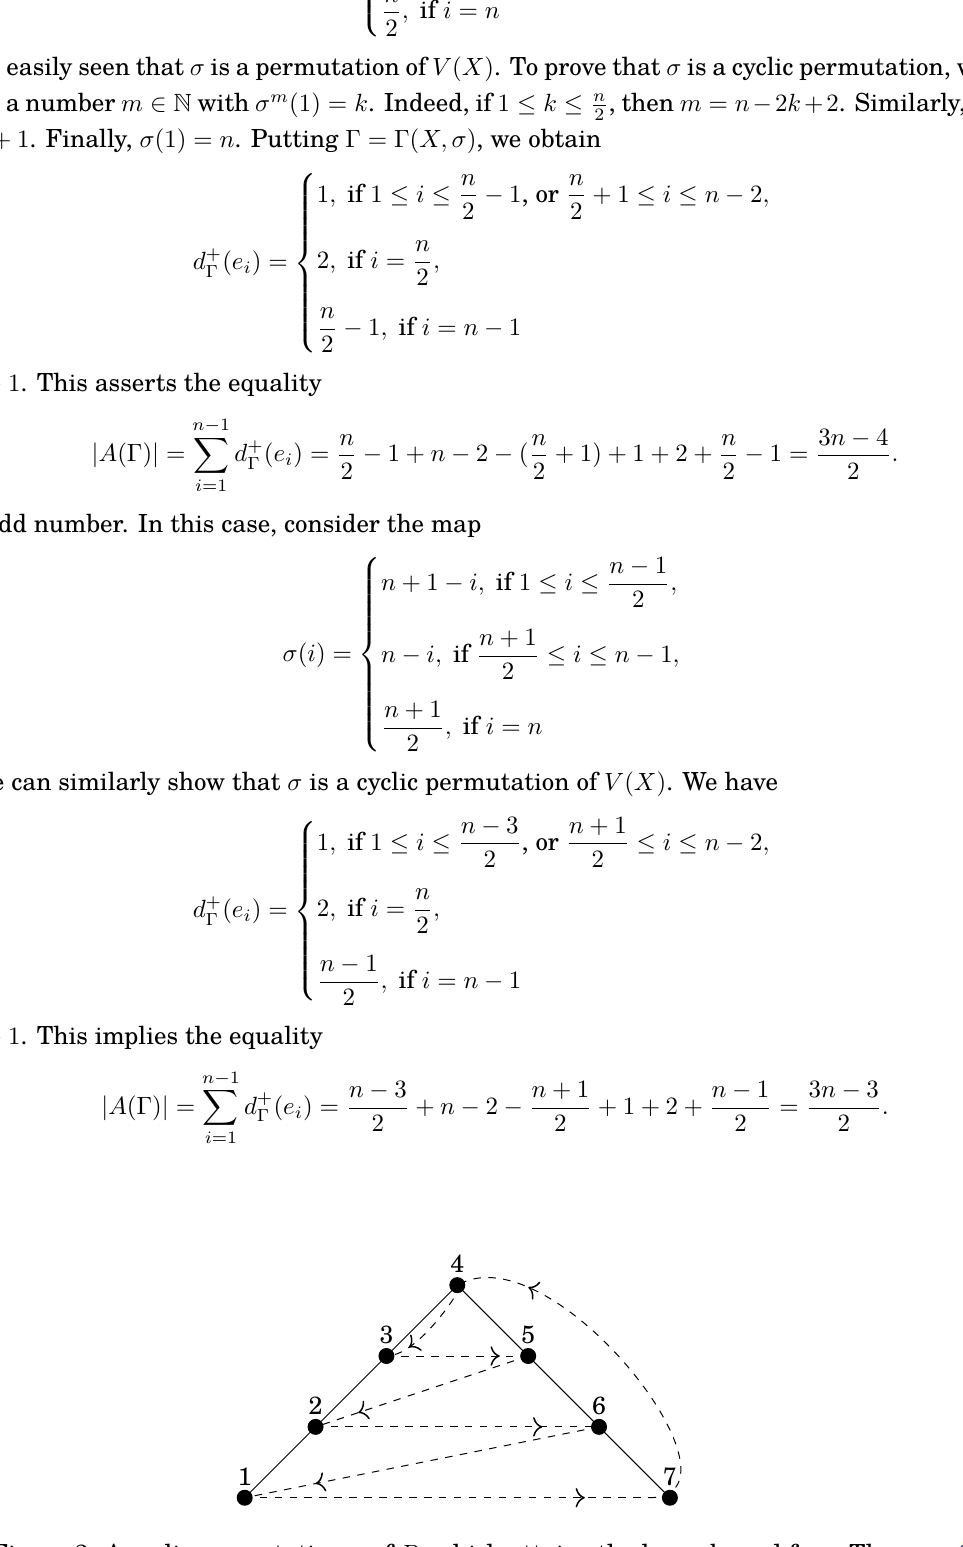
Figure 2: A cyclic permutation σ of P